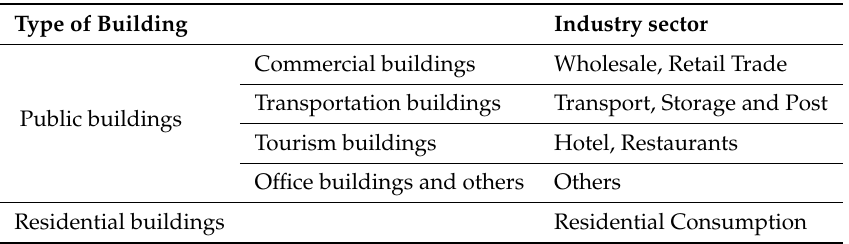
Table 3. The industry sector in the Energy Balance Sheet related to building